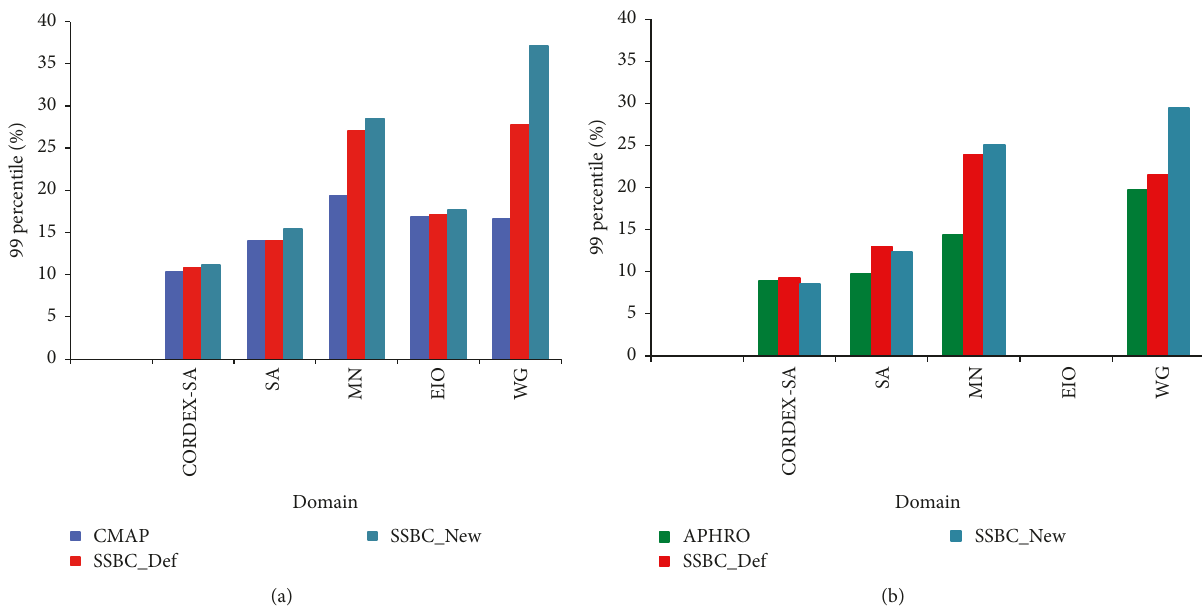
Figure 11: Comparison of 99th percentile surface precipitation over time between SSBC_Def and SSBC_New (1981–1990) for CORDEX-SA and its subdomains with (a) CMAP and (b) APHRODITE surface precipitation (mmday −1 ). The 𝑦 -axis units are in %